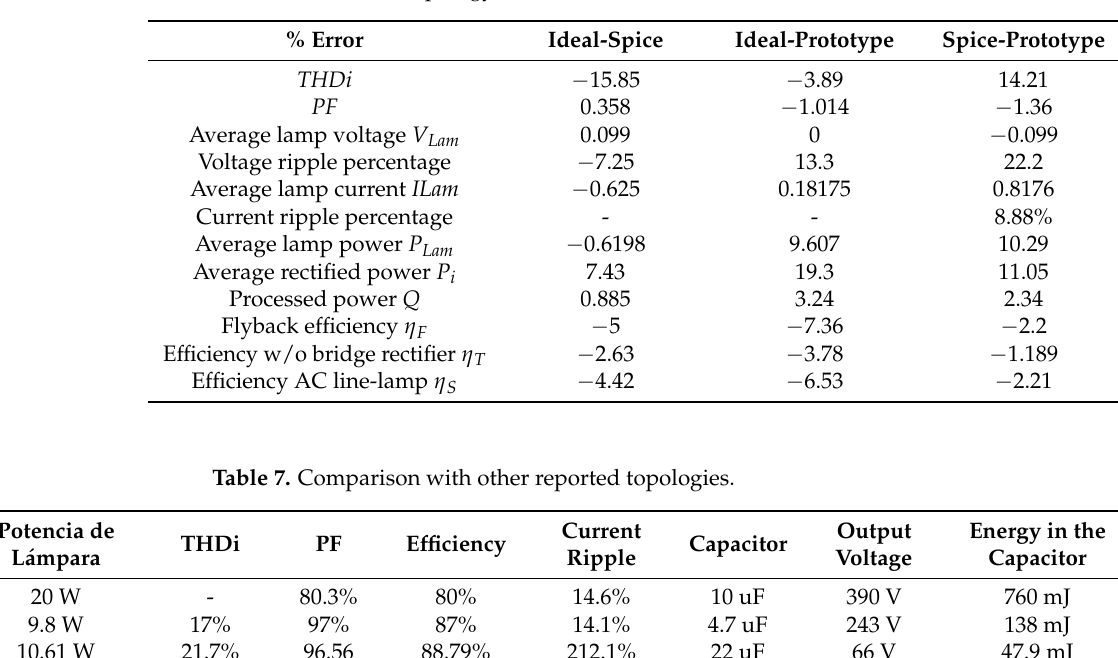
Table 6. Error rates in the topology.